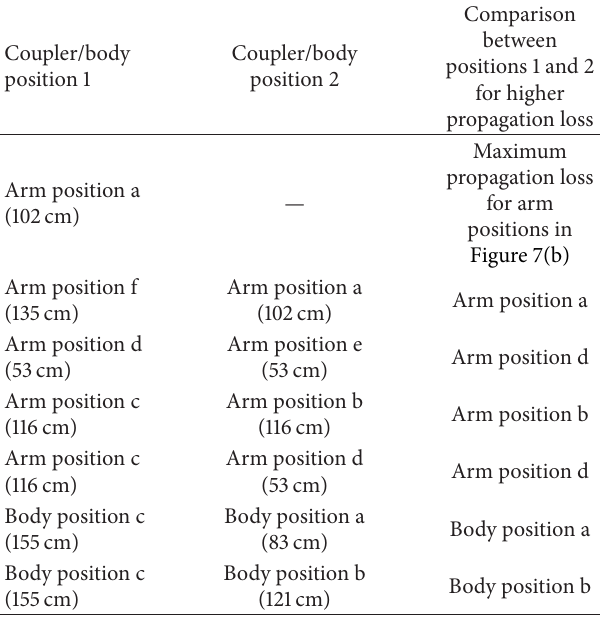
Table 2: Comparison of specific coupler/body positions in Figures 7(b) and 7(d) for higher propagation